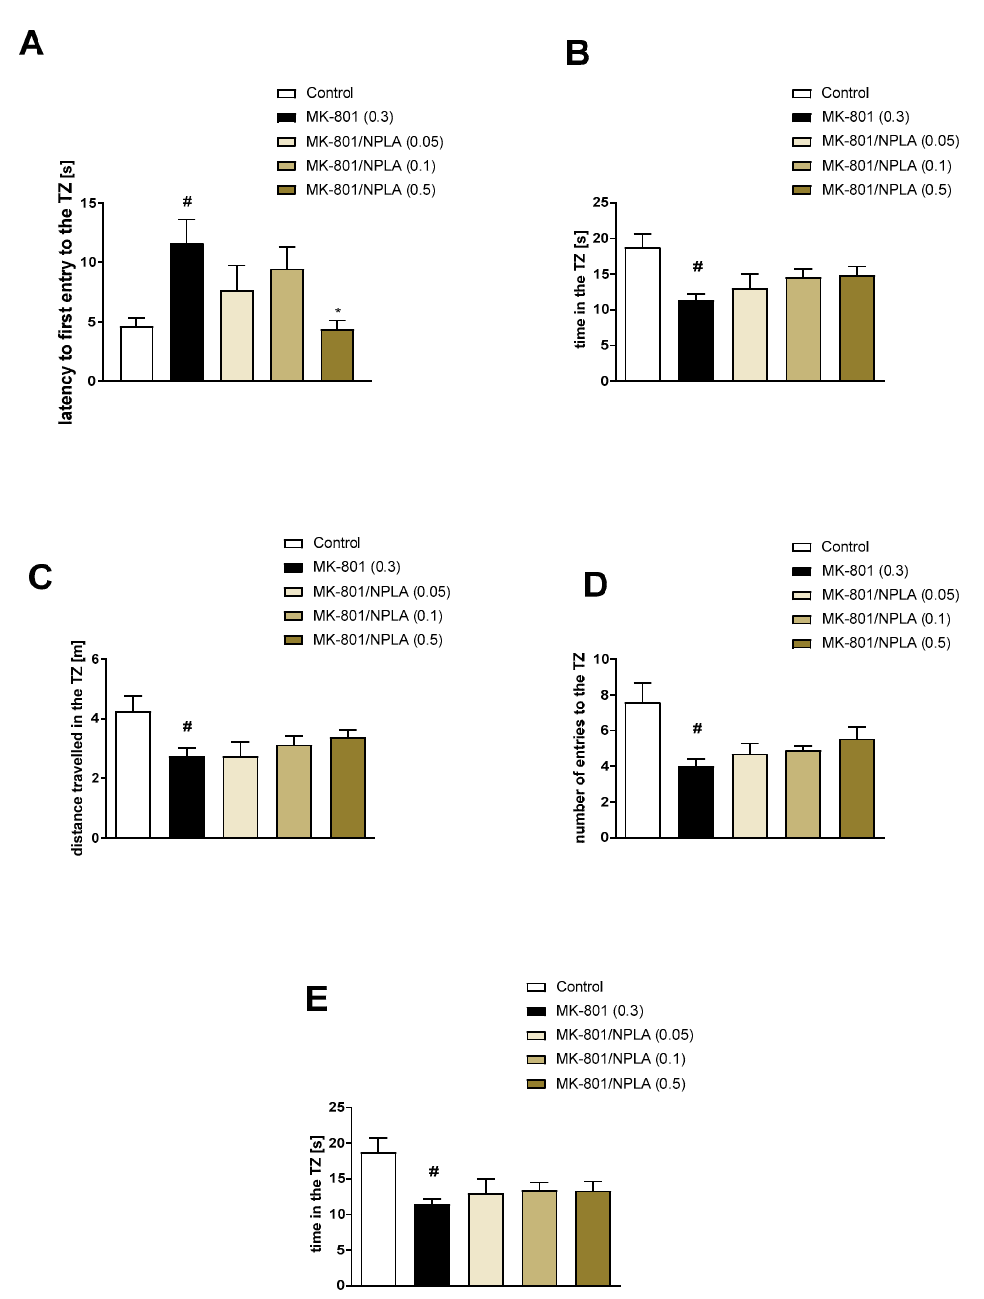
Figure 10. The effects of NPLA on MK-801-induced deficits in the retention of spatial memory in the MWM of CD1 mice. TZ-related parameters. ( A ) the latency to the first entry into the TZ, ( B ) the time in the TZ, ( C ) the distance travelled in the TZ, ( D ) the number of entries into the TZ, and ( E ) the time oriented towards the centre of the TZ when inside the zone. The values are expressed as the means ± SEM. # p < 0.001 vs. control group and * p < 0.05 vs. scopolamine-treated animals (N = 7–9). Spermine NONOate reversed the effect of MK-801 on the latency to first entry into the TZ at a dose of 0.5 mg/kg [F (3.31) = 3.9; p = 0.01] (Figure 8). No activity regarding the time in the TZ [F (3.31) = 1.14, p = 0.34], the distance travelled in the TZ [F (3.31) = 1.35, p = 0.27], the number of entries into the TZ [F (3.31) = 3.1, p = 0.03], or the time oriented towards